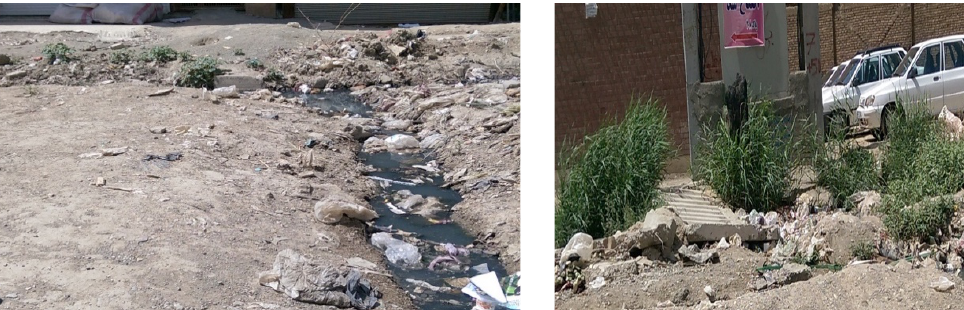
Figure 4. Sludge in the alleys' surface Figure 5 . Inappropriate vegetation in the streets